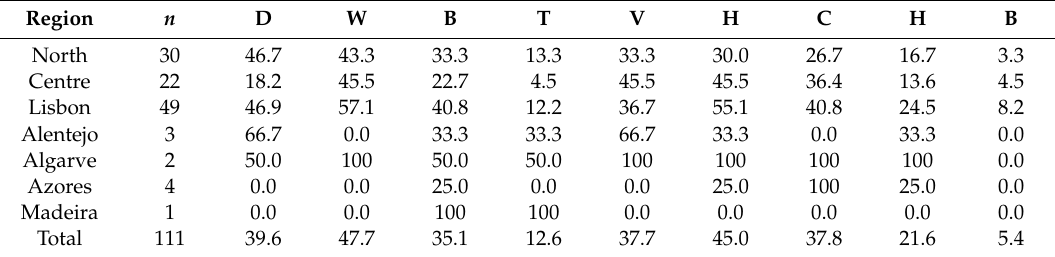
Table 7. Portuguese pet owners (%) reporting being interested in learning new information on a